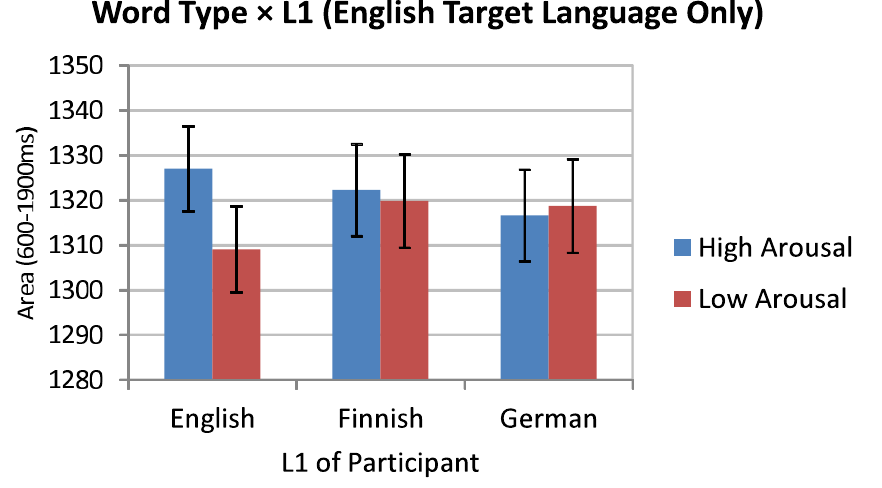
Fig 5. Estimated marginal means (with 95% CIs) for the L1 × Word Type Interaction. (Analysis considering English target language only). Dependent variable was the pupil size area under the curve from 600-1900ms after stimulus onset. Means and CIs are